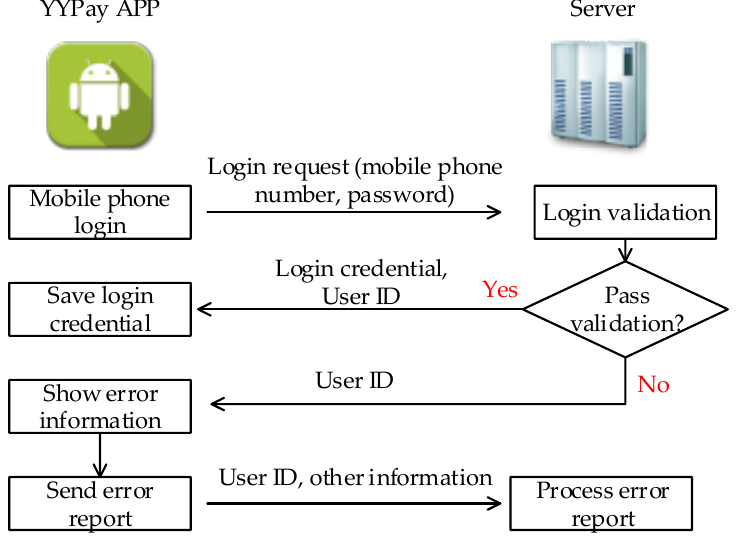
Figure 8. Login model of YYPay.